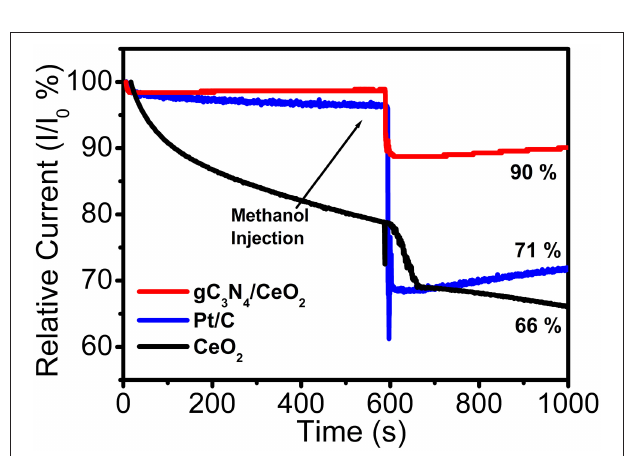
FIGURE 10 | Nyquist plot of as prepared electrocatalyst at − 0.21V vs. Ag/AgCl measured in 0.1M KOH solution. Inserted: A simplified equivalent